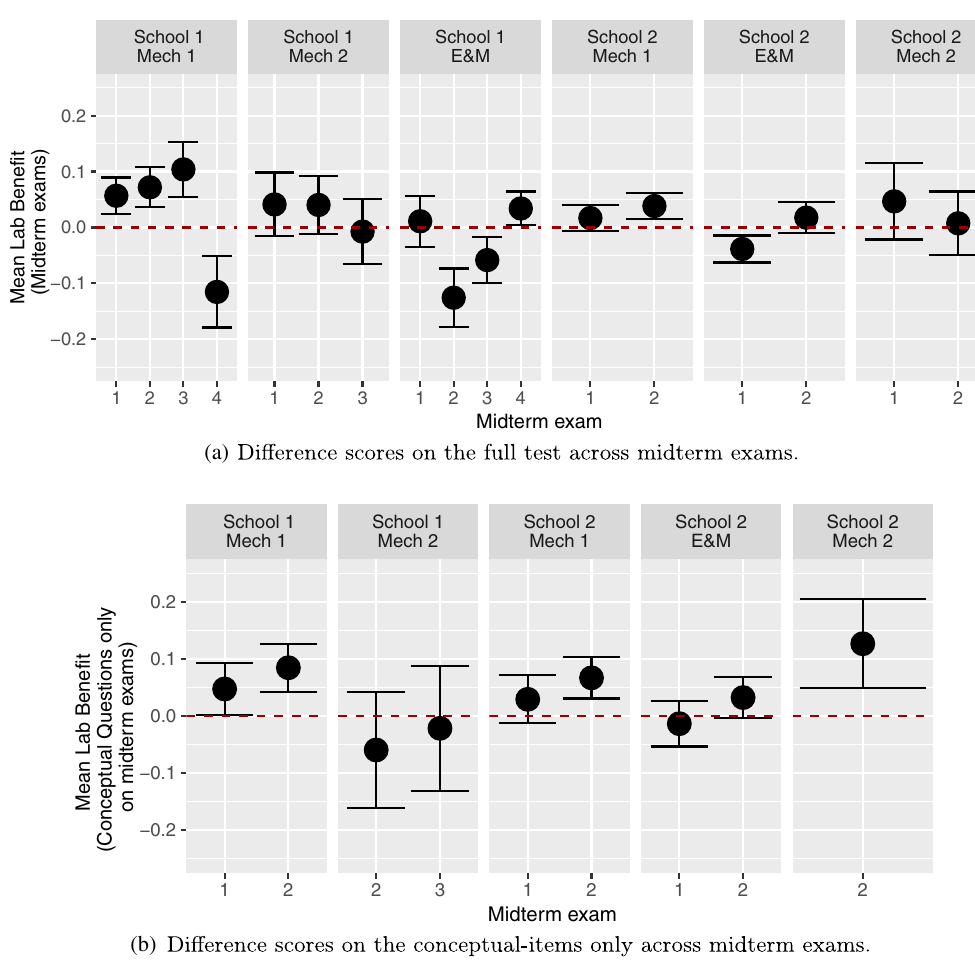
FIG. 3. The mean lab benefit [Eq. (2)] across midterms for six courses at two institutions for (a) the full exams and (b) the conceptual items only. Not all midterm exams had sufficient conceptual questions to be included in the analysis. Error bars represent the standard error (or standard uncertainty in the mean). The dashed line indicates the hypothesis being tested (whether the mean lab benefit differs significantly from